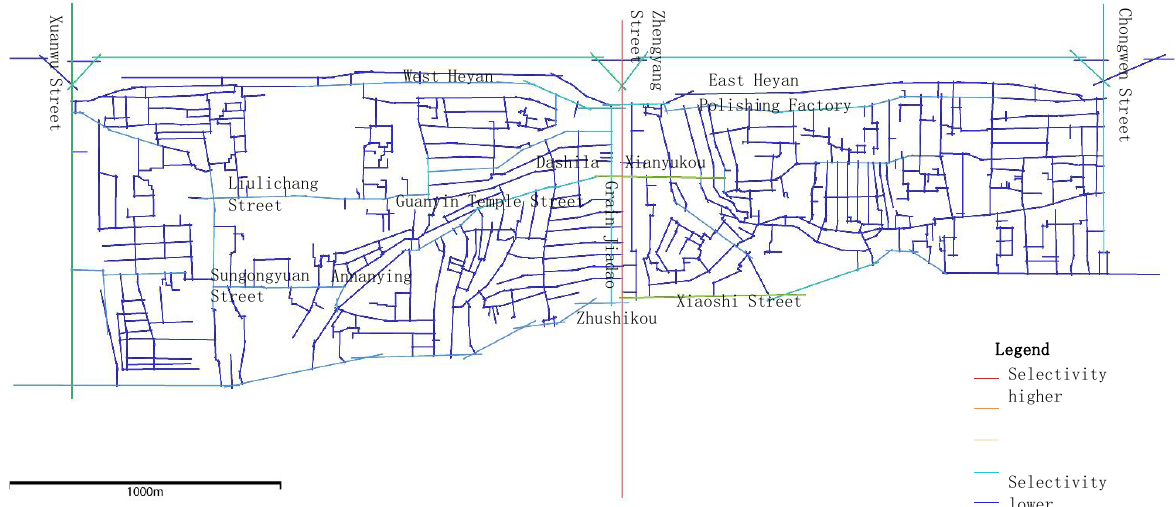
Figure 5. Selectivity map of streets and alleys in Qianmen area during the Qianlong